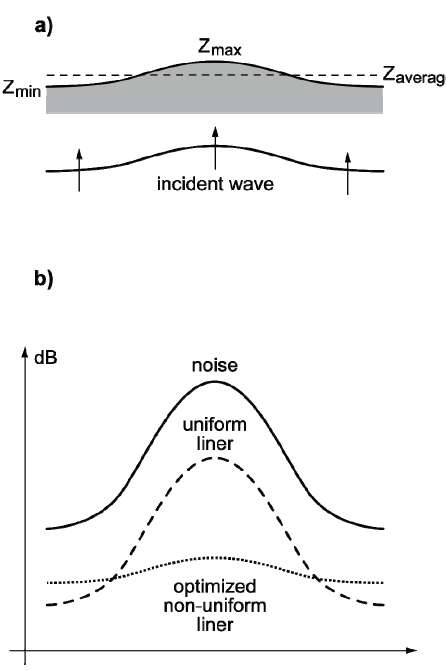
Figure 12. Optimization of a non-uniform acoustic liner. As acoustic liner carries